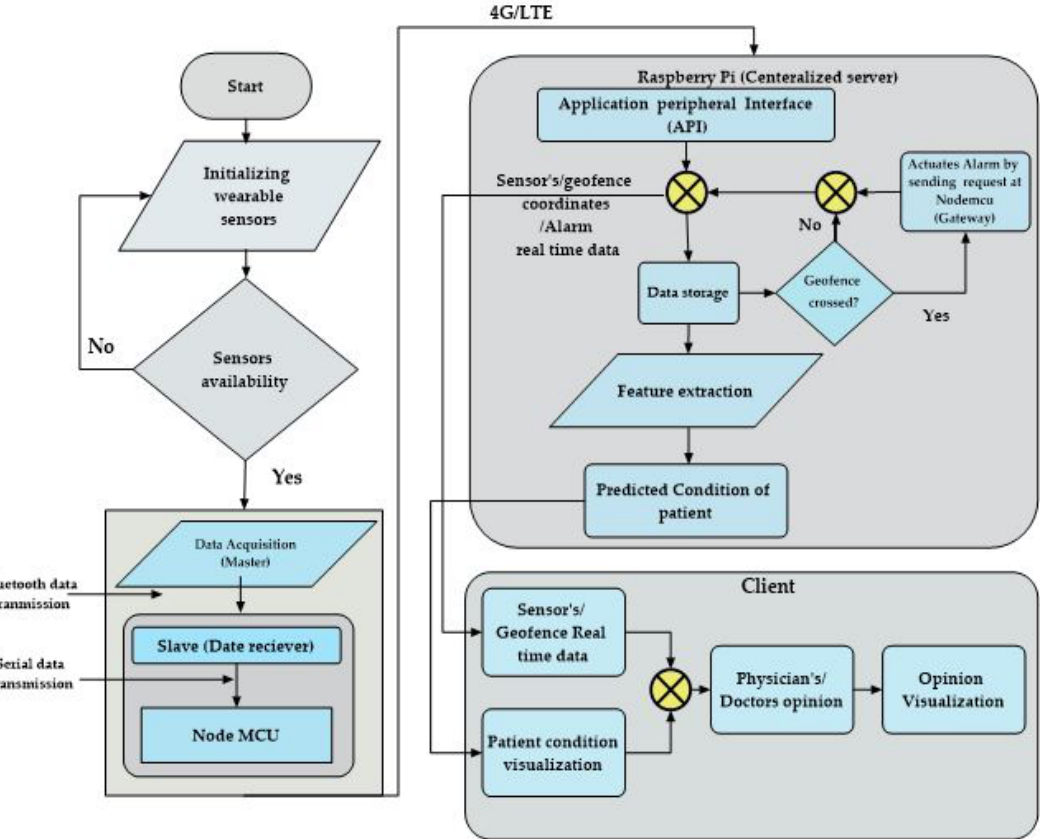
Figure 6. Algorithmic flow chart of the proposed wearable sensors placement and WIoT based framework for Geo-fencing and Remote Monitoring of COVID-19 susceptible and patients for health monitoring and quarantine